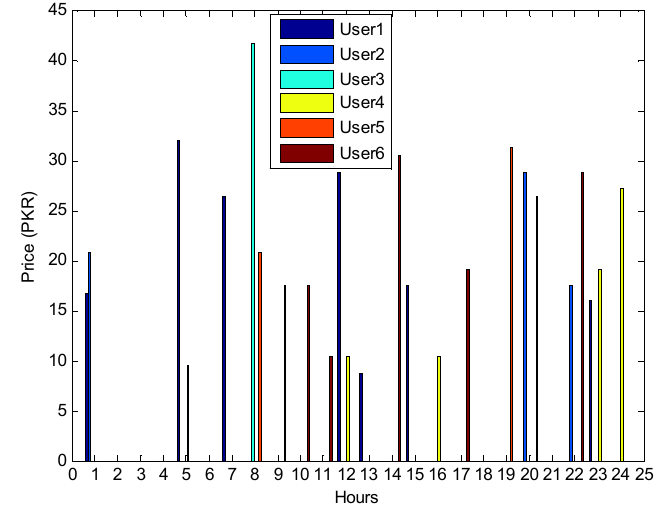
Figure 10. Price of allocated surplus energy.